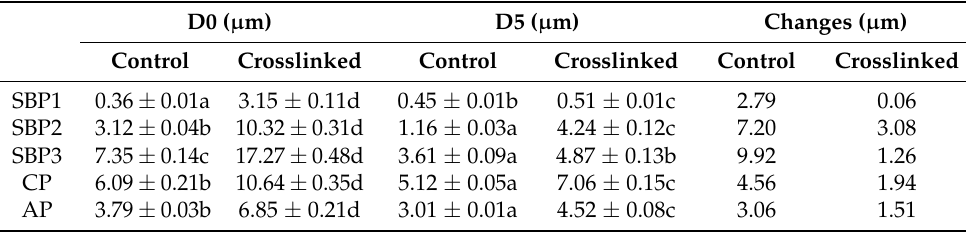
Table 4. Yield and chemical composition of pectin used in this work a